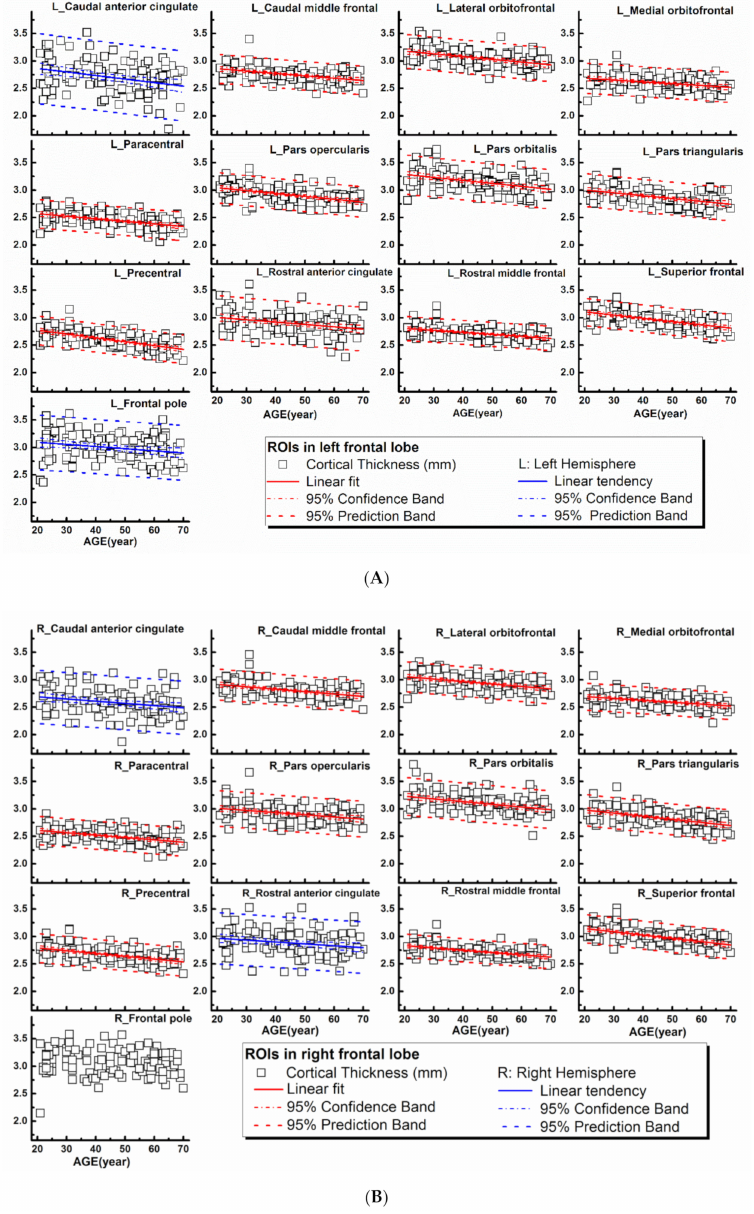
Figure 1. Regional cortical thicknesses ( y -axis, in mm) measured from frontal regions of interest (ROIs) plotted versus age ( x -axis). Corresponding linear fits, the calculated 95% confidence interval bands, and the 95% prediction interval bands were also shown in 25 ROIs, where a significant ( p < 0.0007, 21 ROIs with red lines) or a trend of (0.0007 < p < 0.05, 4 ROIs with blue lines) correlation between the measured values and the age was